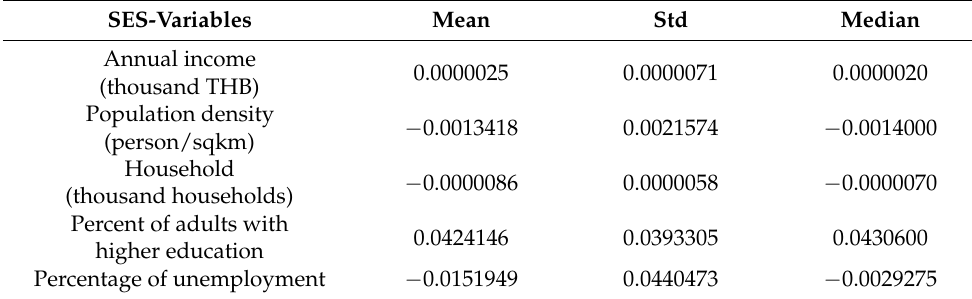
Table 6. Summary of the coefficients of the significant variables measured by